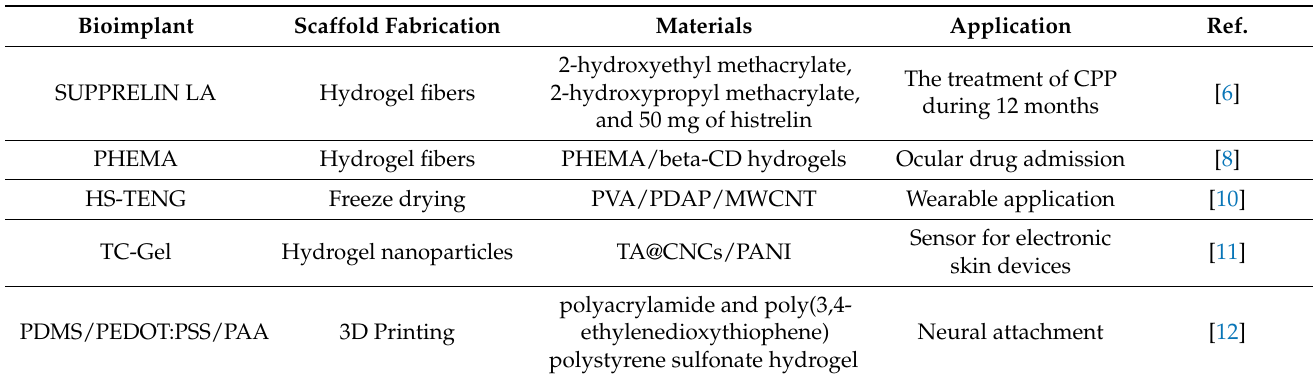
Table 1. A list of the most common commercially available natural self-healing hydrogels. Bioimplant Scaffold Fabrication